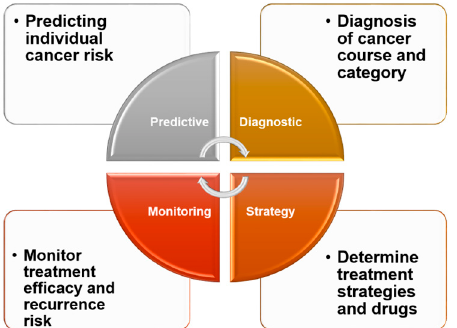
Figure 3. Clinical significance of biomarkers. In clinical practice, biomarkers can be effective and convenient for healthy people, providing insight into their own conditions and the risk of developing diseases. For cancer patients, biomarkers can be helpful in understanding their type of cancer and various tumor processes. From the standpoint of treatment, biomarkers can be an effective tool to aid patients and their doctors in selecting from among different treatment options to reduce drug resistance and increase treatment efficacy. Regular monitoring of various biomarkers in patients receiving treatment can also help patients to understand their own recovery and assess the likelihood of recurrence.